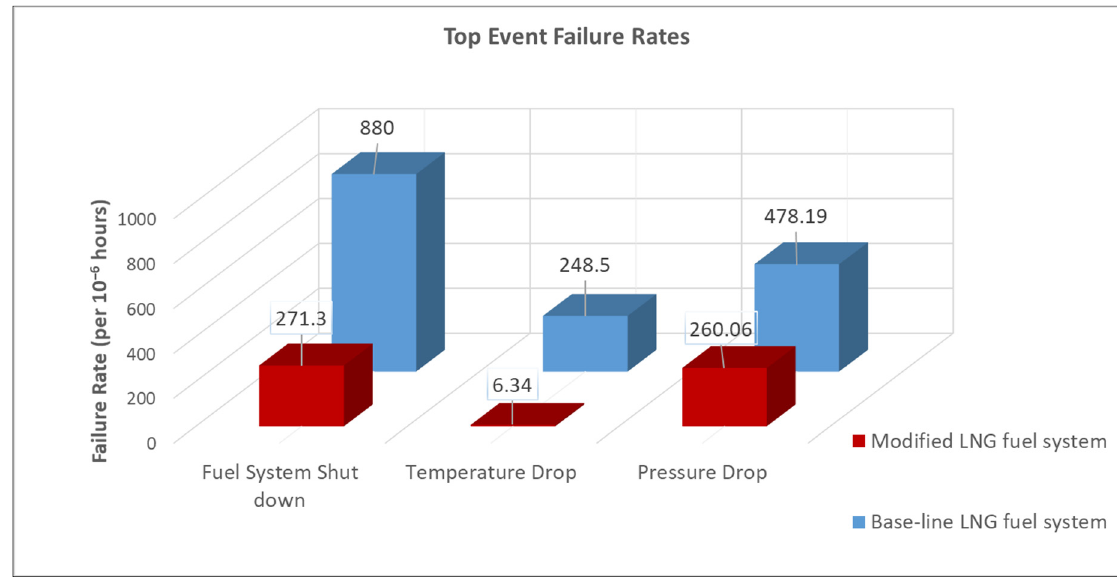
Figure 11. Derived failure rates for the baseline and modified LNG fuel system configurations. Table 8. Enhanced LNG fuel system top event failure rates